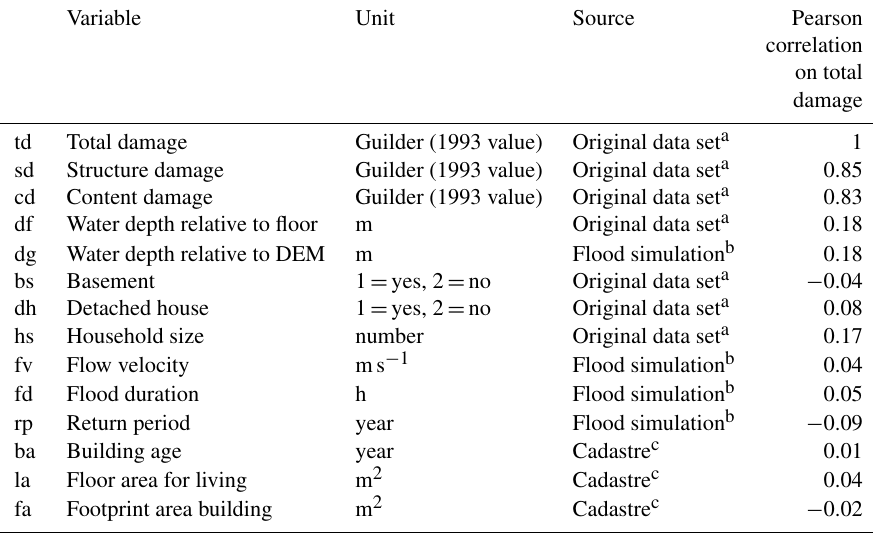
correlation on total